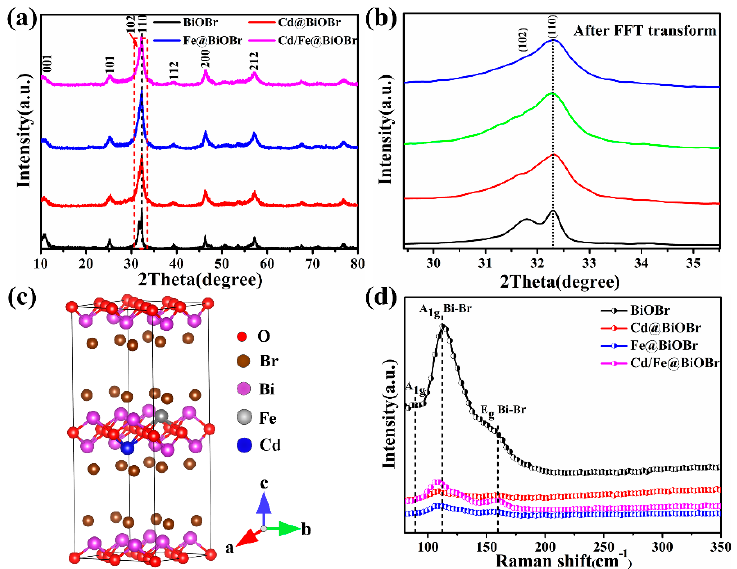
Figure 2. XRD patterns of samples ( a ), enlarged XRD patterns with FFT transform ( b ), the crystalline structure model of the X-doped BiOBr (X = Cd, Fe, Cd/Fe) ( c ), and Raman spectra ( d ). The microstructure of the Bi 1 − x − y Cd x Fe y OBr microspheres was characterized by TEM